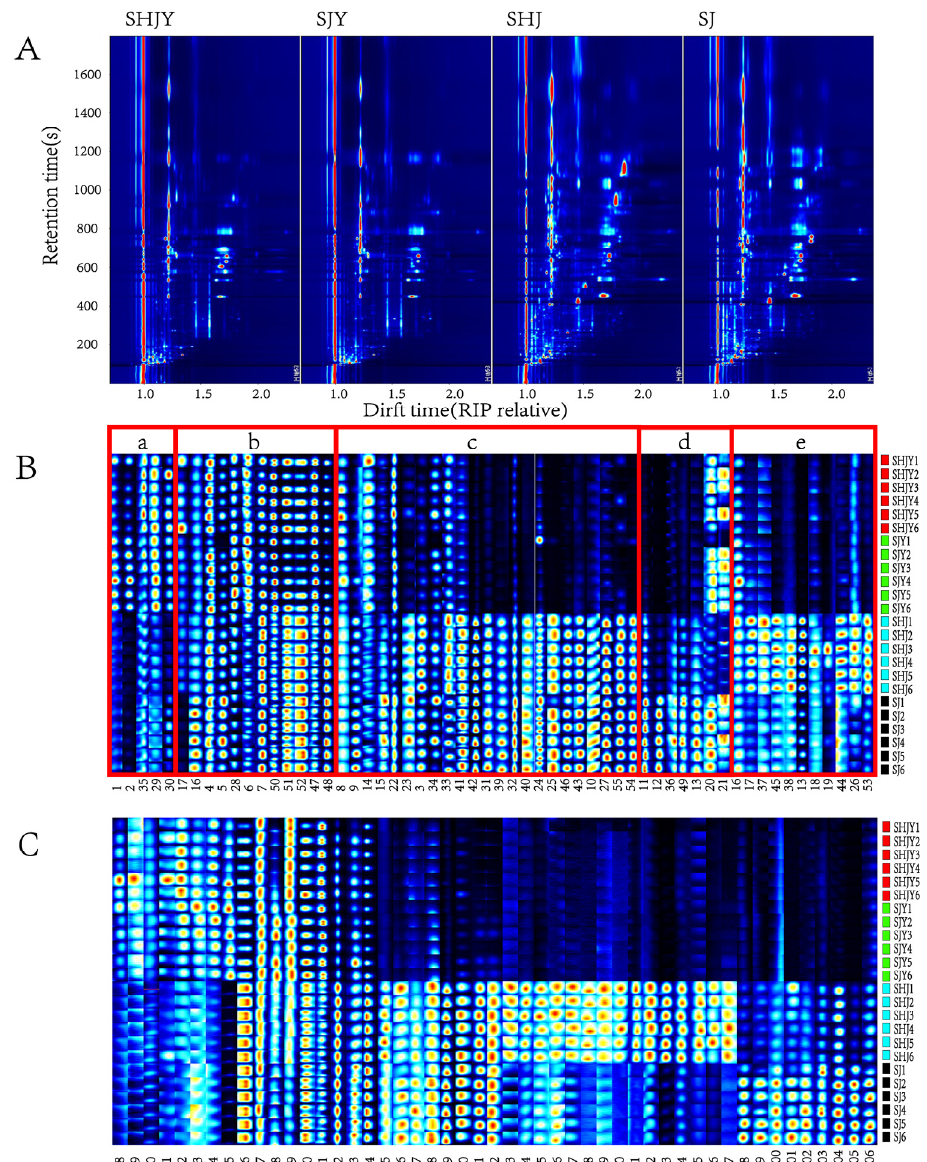
Figure 1. ( A ): topographic of SHJ, SJ, SHJY, SJY detected by HS-GC-IMS; ( B ) and ( C ): gallery plot of SHJ, SJ, SHJY, SJY detected by HS-GC-IMS. The a, b, c, d, and e are significant components of ZBL, ZBP and ZBL, ZBP, SHJ and SJ, respectively, among the identified components. (The codes of the compounds correspond to those in Table